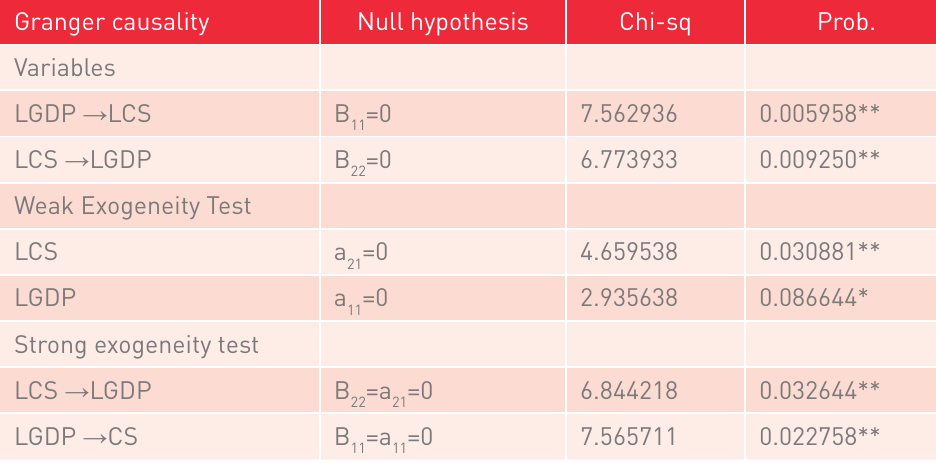
Causality and Exogeneity